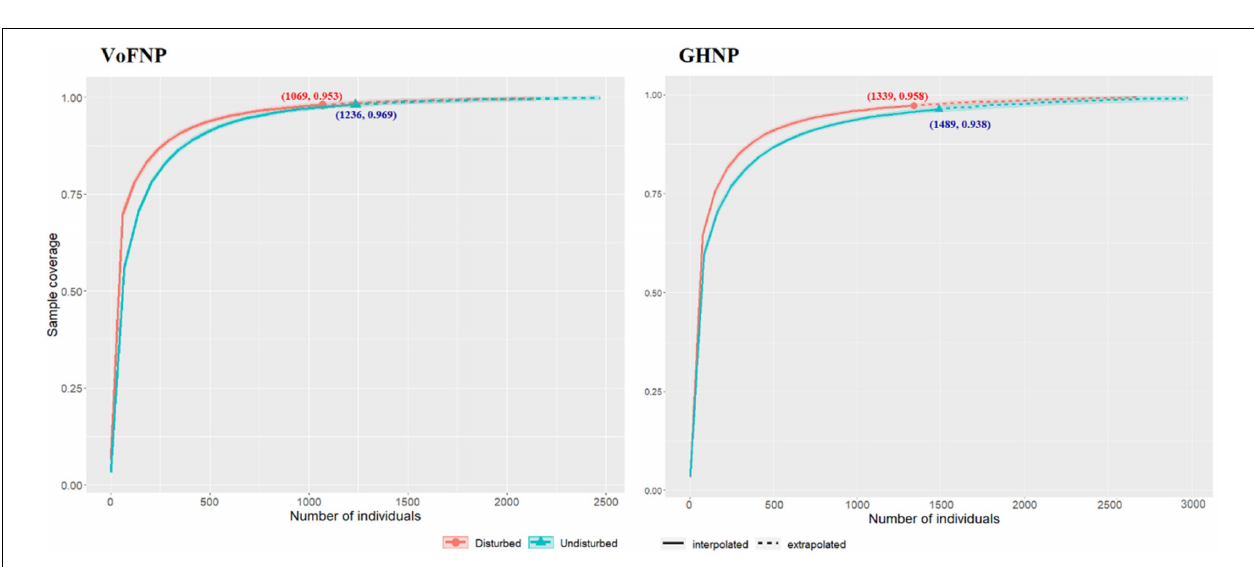
FIGURE 6 | Sample coverage for rarefied samples (solid line) and extrapolated samples (dotted line) as a function of sample size for disturbed and undisturbed sites in VoFNP and GHNP. 95% confidence intervals (shaded areas) are obtained by a bootstrap method based on 200